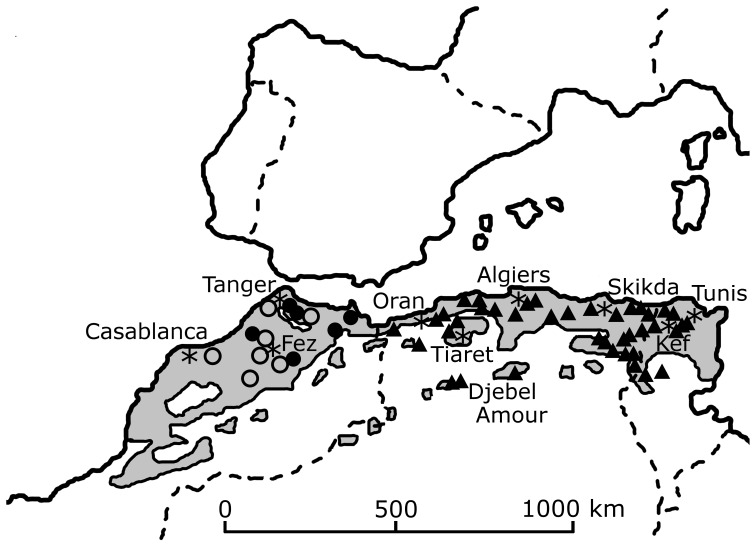
Distribution of historical reports of lions in North Africa (AD 1500–1900).Grey shading indicates Mediterranean scrubland ecosystems [8]. Earliest accounts in the western Maghreb from 16th to the 18th century are indicated as open circles [7], [19]. Documented sightings in known years from 1800 to 1900 are indicated as black circular markers in the western Maghreb (1–7 in Table 1); triangular markers indicate sightings in eastern Maghreb (22–133 in Tables 2–6). Asterisks (*) denote locations of human population centers. Dashed lines indicate national boundaries.